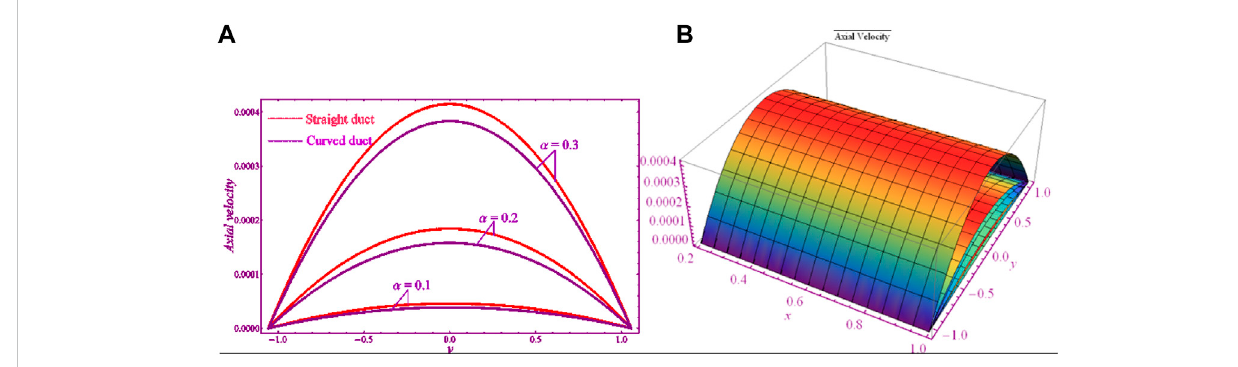
Axial velocity pro fi le for the aspect ratio, α . (A) 2D. (B) 3D.